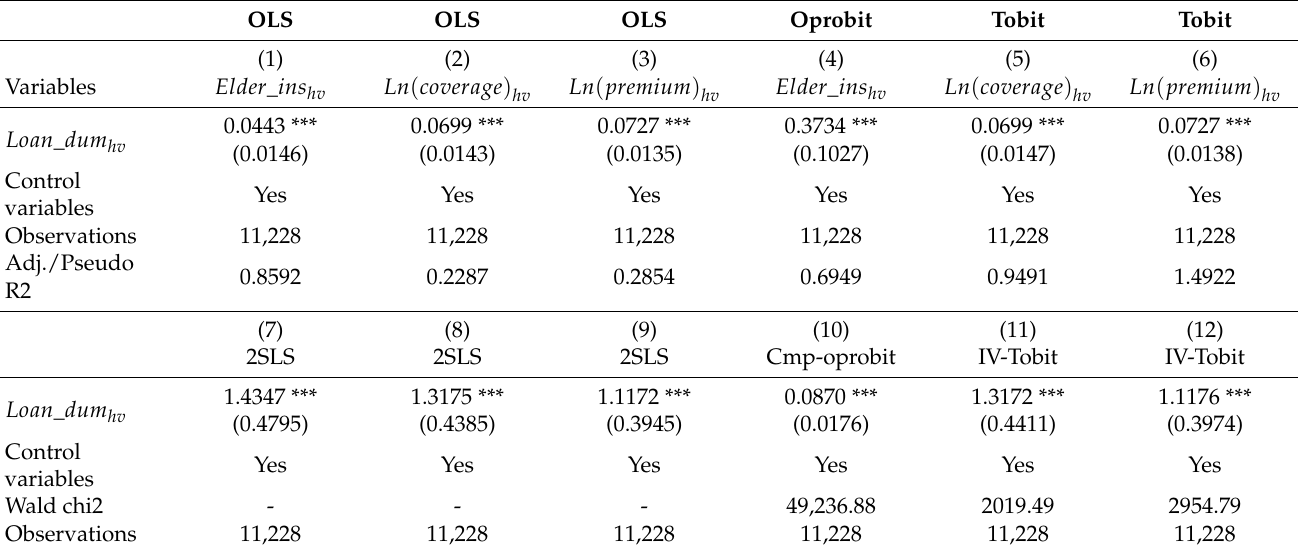
Table 10. The effects of microcredit on other types of health